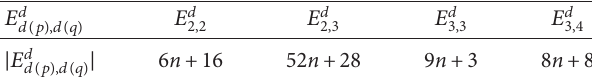
Table 3: Partitions of H ’s edges according to the